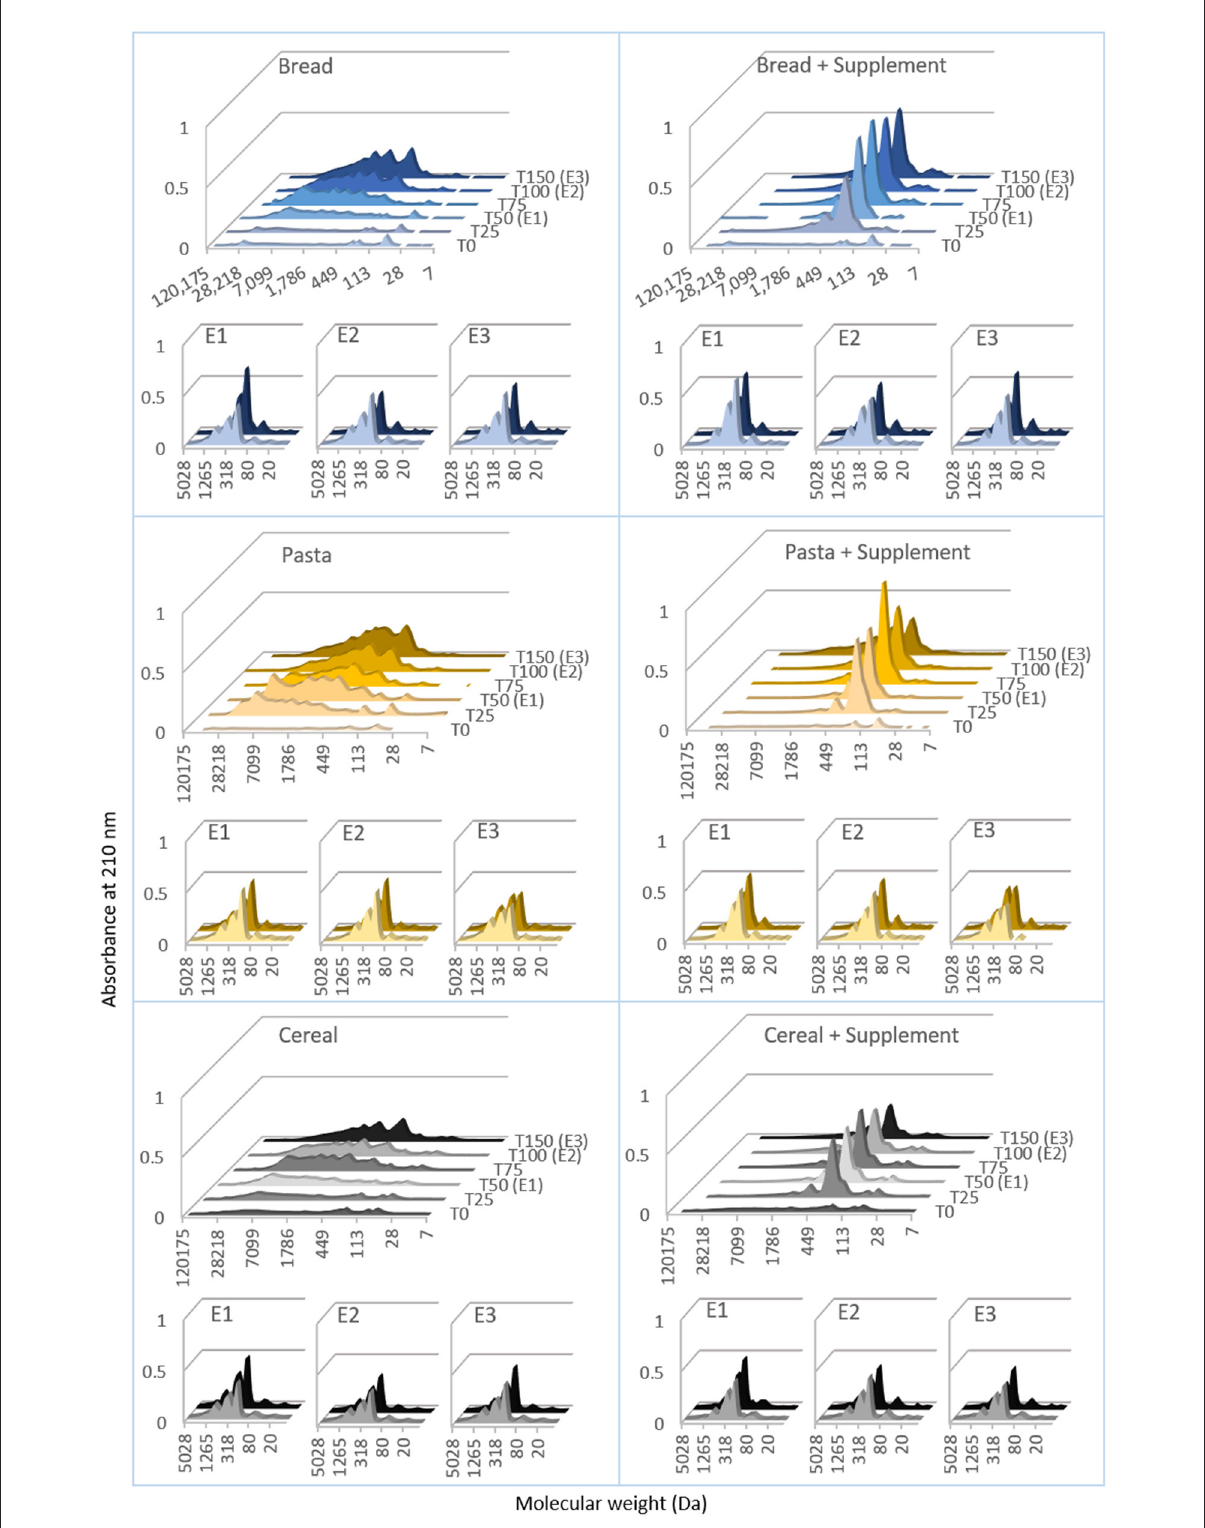
FIGURE5 Molecular mass distributions of proteins during semi-dynamic in vitro digestions of bread, pasta and breakfast cereal. The molecular mass distribution of proteins in the digesta was estimated by size exclusion chromatography, high performance liquid chromatography (SEC-HPLC).